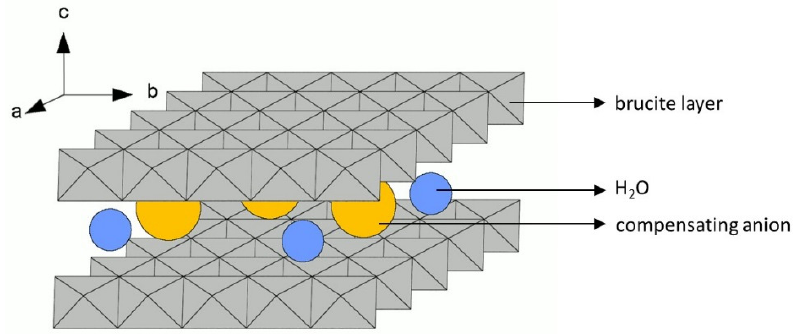
Figure 1. Schematic illustration of HT structure.